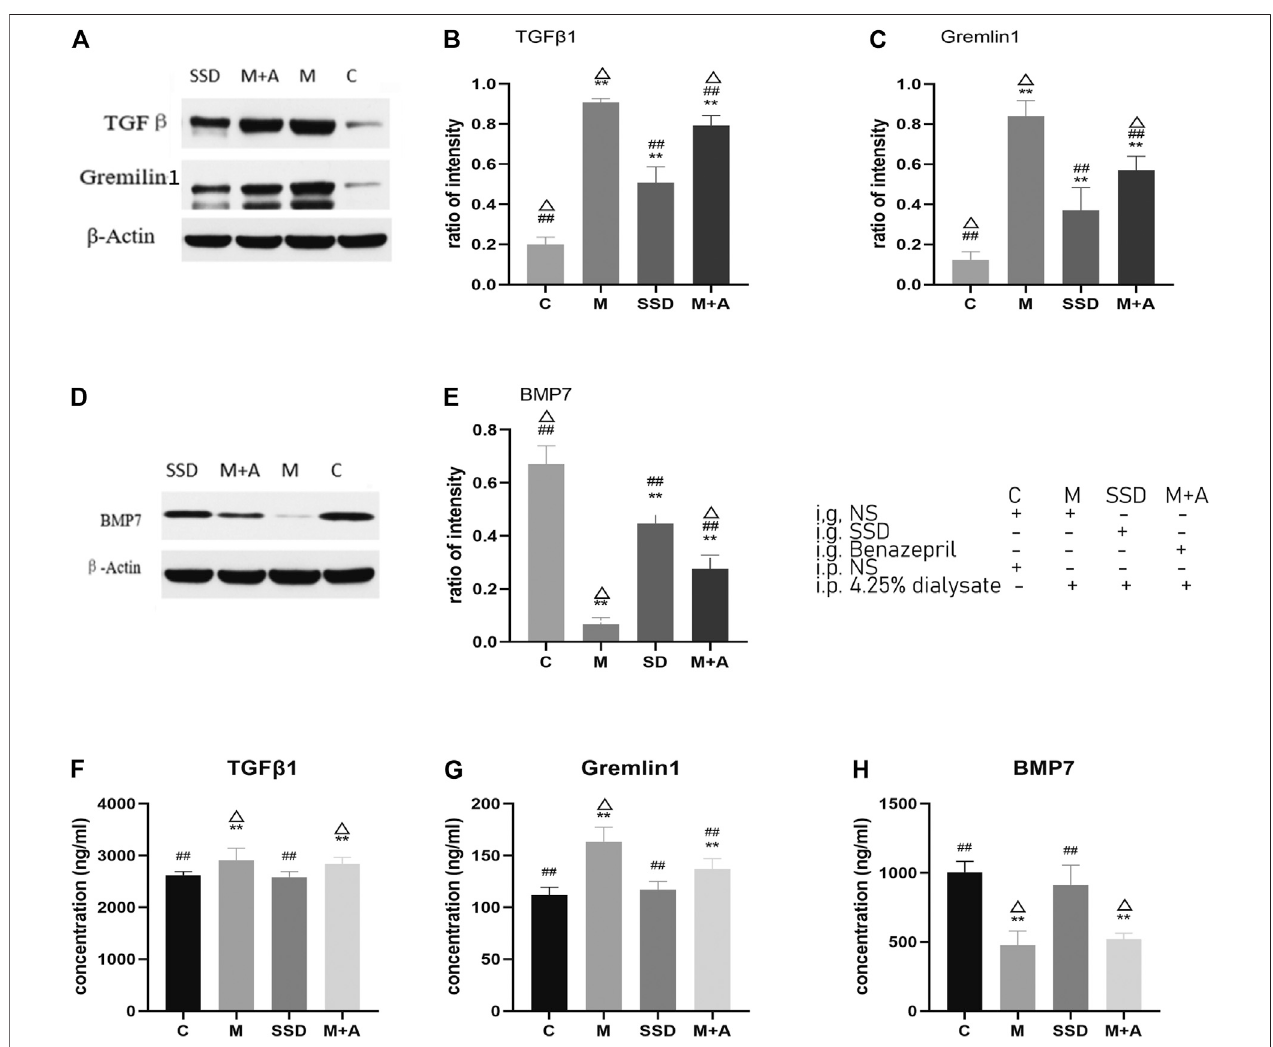
FIGURE 3 | (A) WB ofTGF β 1 and Gremlin1; β -Actin was used as the loading control. (B,C) Protein levels of TGF β 1 and Gremlin1 in each group. (D) WB of BMP7. (E) Quanti fi cationofproteinlevelsofBMP7ineachgroup. (F – H) ELISAresultsofTGF β 1,Gremlin1,BMP7. n (cid:2) 8ForcomparisonwiththegroupM,##indicates p < 0.01; for comparison with the C group, ** indicates p < 0.01, for comparison with the SSD group, △ indicates p <